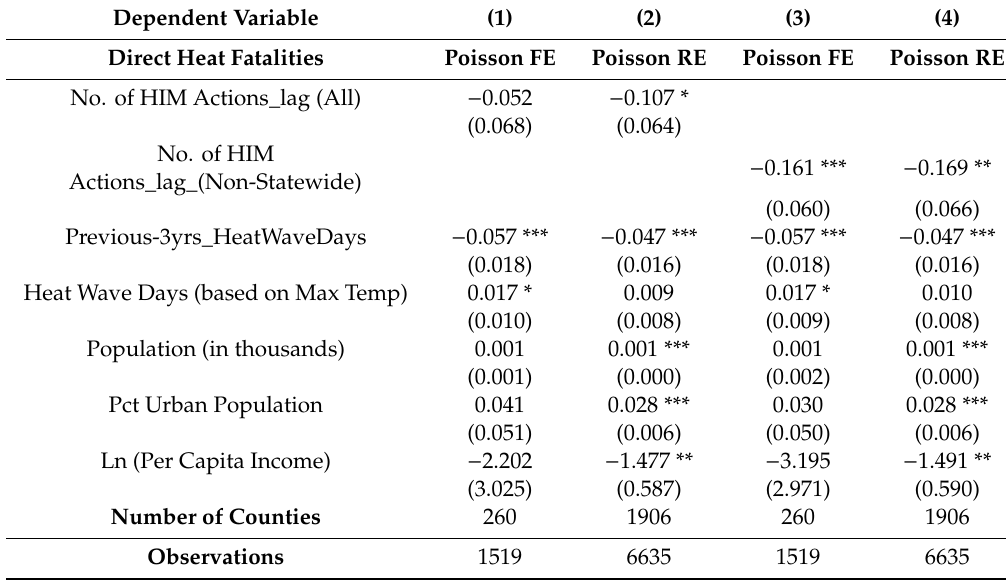
A direct estimation of the e ff ect of heat island mitigation (HIM) actions on heat fatalities–Poisson fixed (FE) and random (RE) e ff ects model key